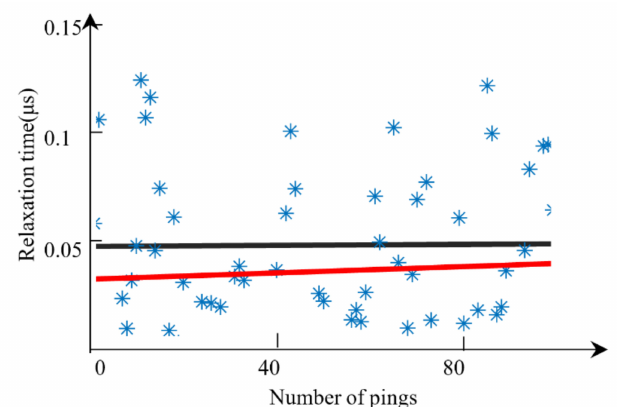
Figure 13. Illustration of the robust line fitting. The black line is the classical line fitting, while the red line is the robust line fitting.